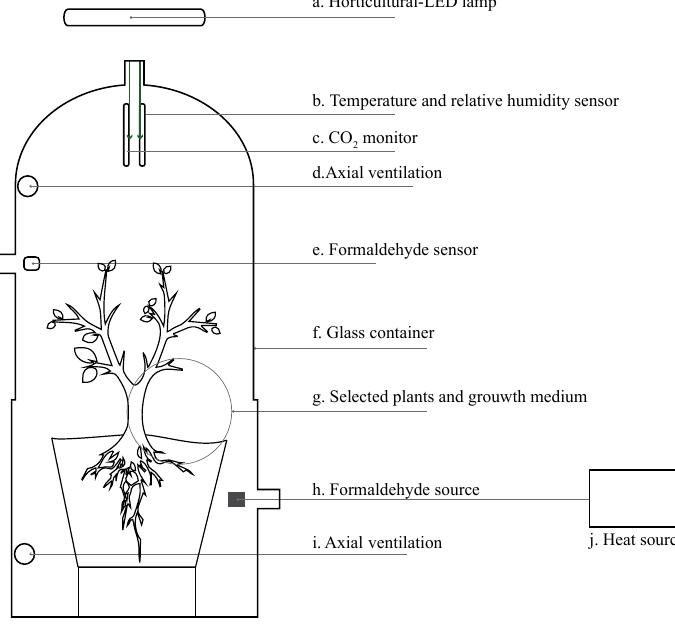
Figure 1. Schematic view of the experimental setup.